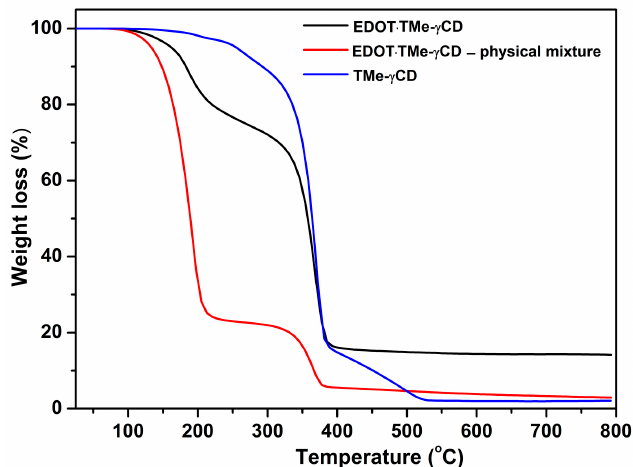
Figure 6. Thermograms of the EDOT ∙ TMe- γ CD inclusion complex (black line), physical mixture (red line), and TMe- γ CD (blue line). Table 1. Thermogravimetric data of EDOT ∙ TMe- γ CD, physical mixture, and the TMe- γ CD.